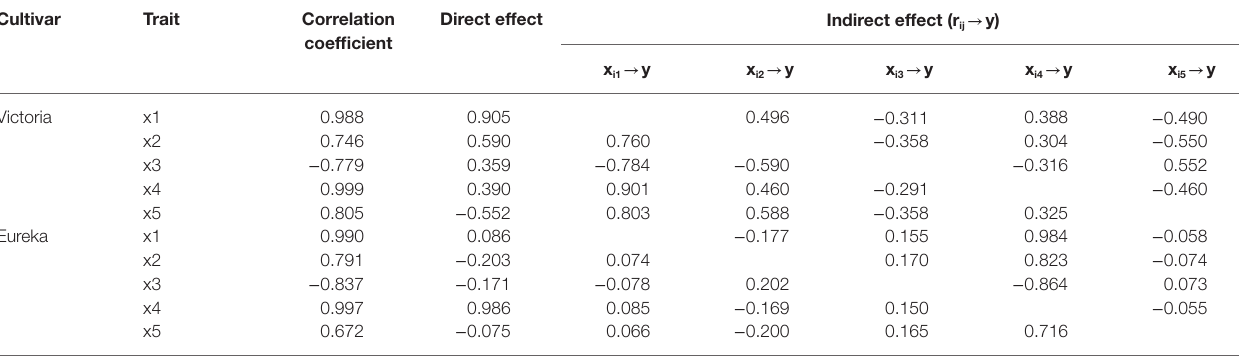
TABLE 4 | Path analysis of seed yield per plant and flowering factors of two alfalfa cultivars. Cultivar Trait